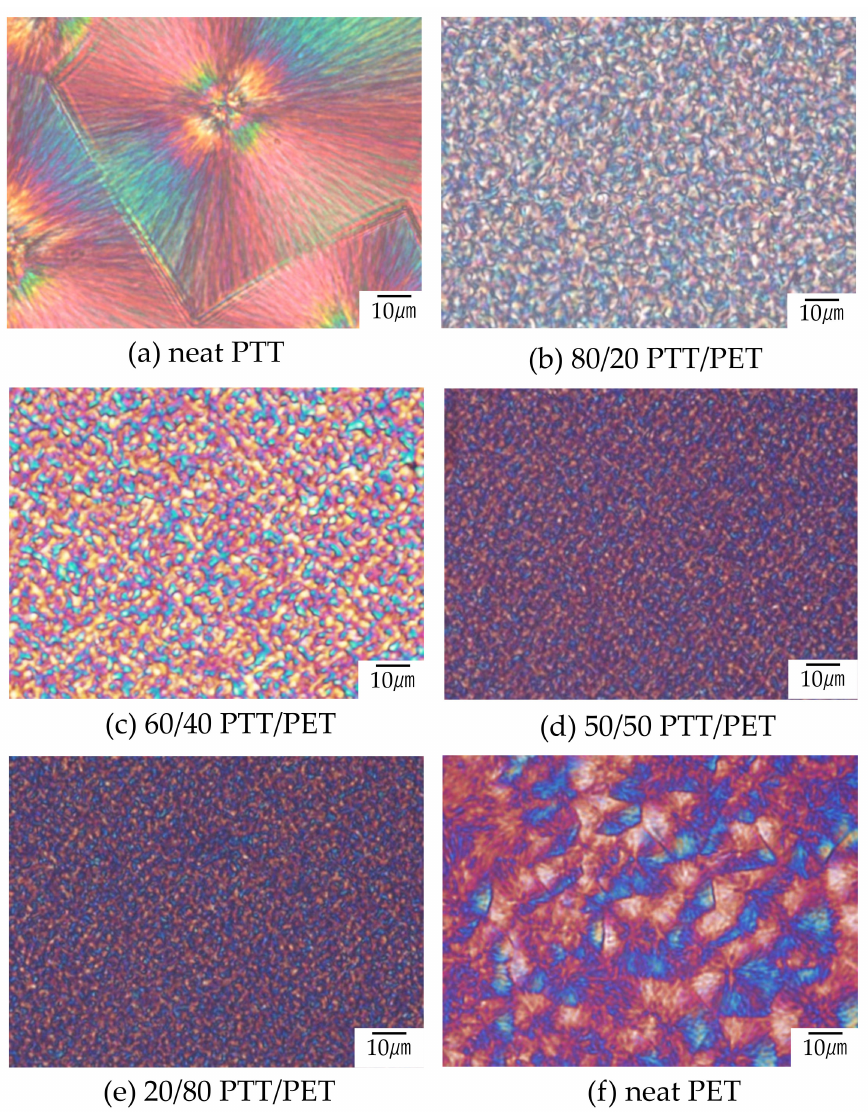
Figure 2. Polarized optical micrographs of ( a ) neat PTT, ( b ) 80 / 20 PTT / PET, ( c ) 60 / 40 PTT / PET, ( d ) 50 / 50 PTT / PET, ( e ) 20 / 80 PTT / PET and ( f ) neat PET obtained by isothermal annealing at 180 ◦ C from the melt state at 300 ◦